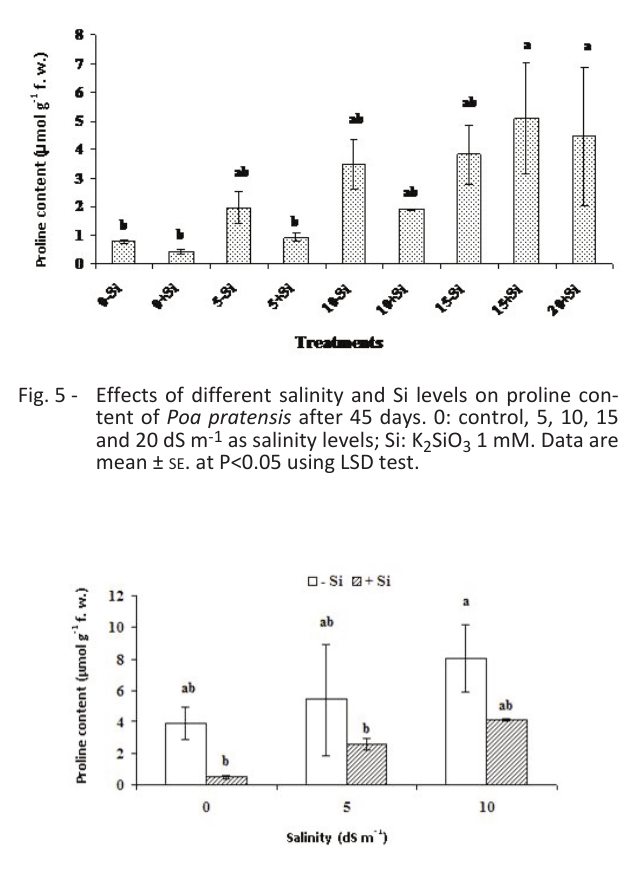
Fig. 6 - Interaction effects of different salinity and Si levels on proline content of P. pratensis after 90 days. Data are mean ± SE at P ≤0.05 using LSD test.